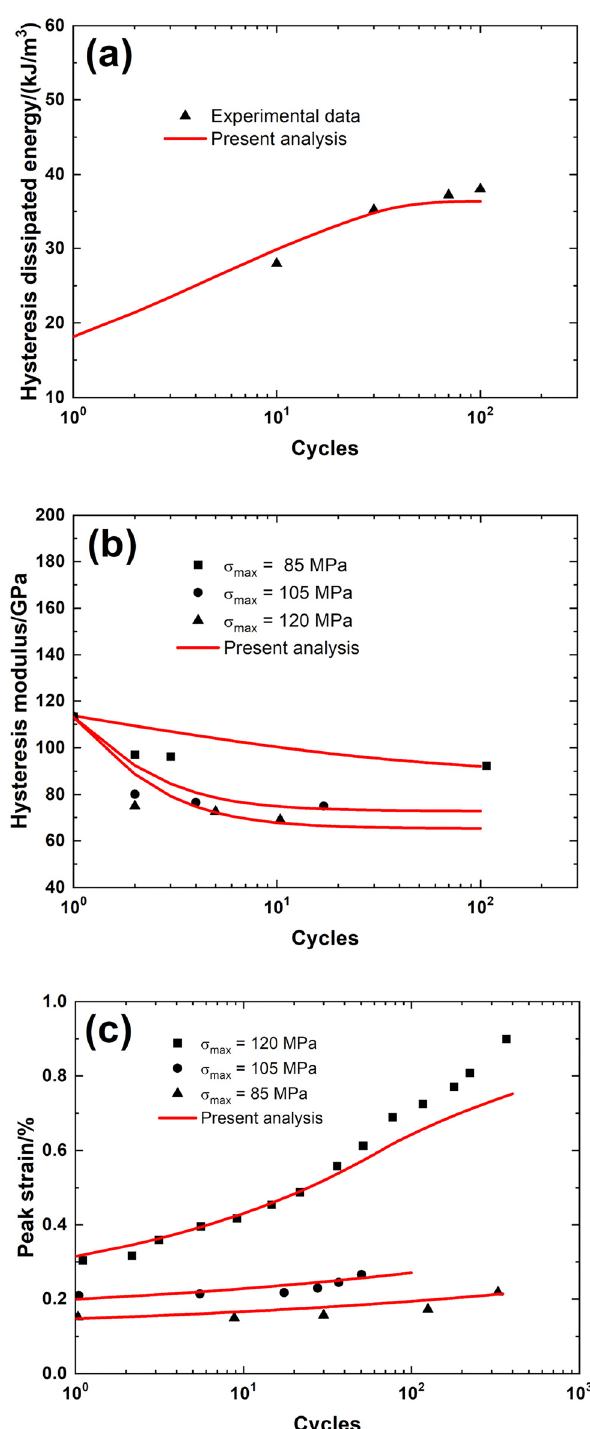
Figure 4: ( a ) The FHDE versus applied cycle curves, ( b ) the FHM versus applied cycle curves, and ( c ) the FPS versus applied cycle curves of cross - ply SiC/MAS composite under IP - TMF loading.